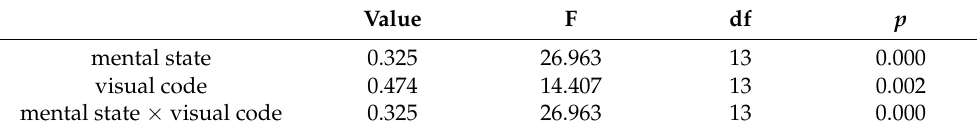
Table 5. Multivariate ANOVA results for accuracy rates of mental state and visual code.